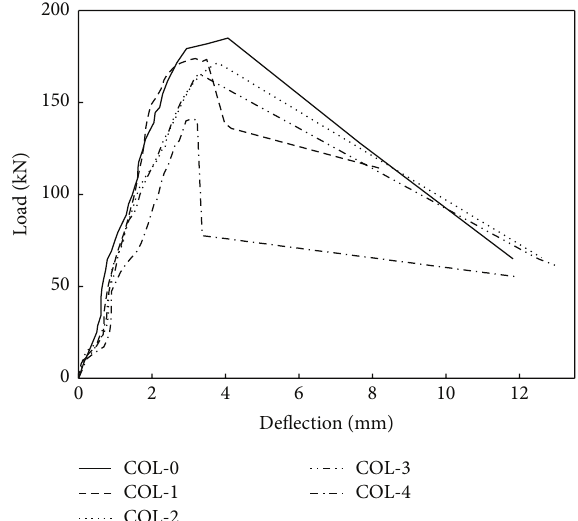
Figure 12: Load-deflection curves of column